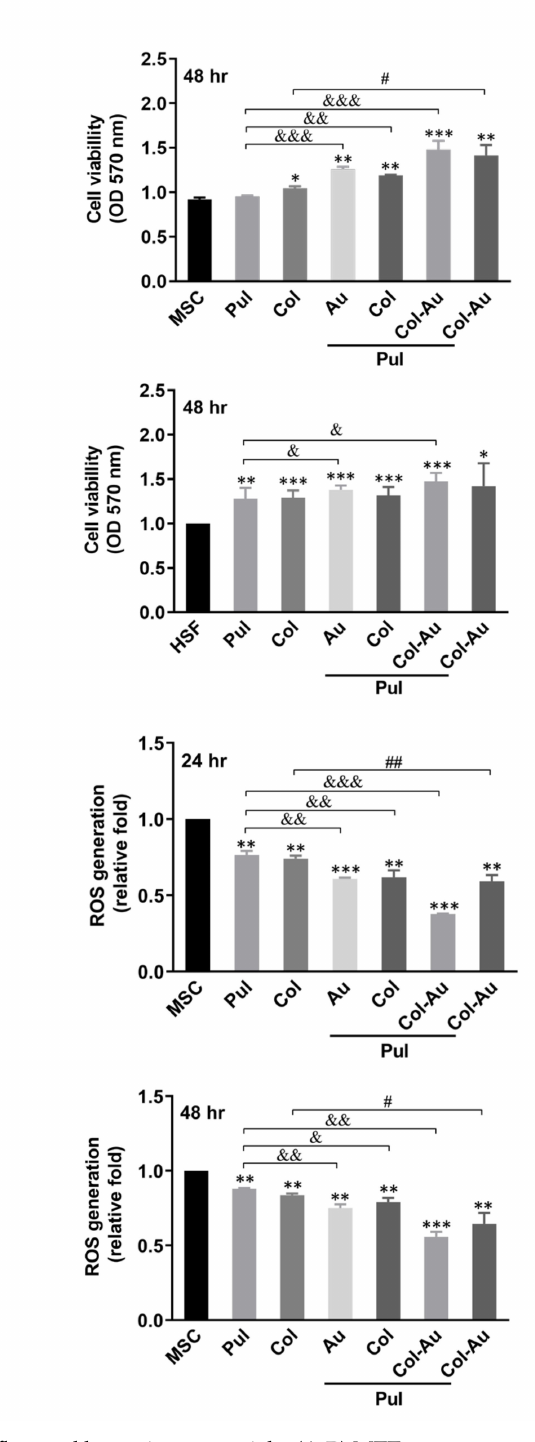
Figure 3. Biocompatibility assessments of MSCs and HSFs influenced by various materials. ( A , B ) MTT assay was applied to investigate the cell viability at 24 and 48 h. The results demonstrated the cell viability were the greatest for MSCs and HSFs in the Pul–Col–Au group at both time points. Data are represented as mean ± SD of the three independent experiments. ( C , D ) The intracellular ROS generation was detected by DCFH-DA and flow cytometry at 24 and 48 h. The semi-quantitative data indicates that Pul–Col–Au induced the lowest production in both HSFs and MSCs. Data are represented as mean ± SD of the three independent experiments. * p < 0.05, ** p < 0.01, *** p < 0.001: compared to MSC or HSF alone group. & p < 0.05, && p < 0.01, &&& p < 0.001: compared to Pul group. # p < 0.05, ## p < 0.01: compared to Col